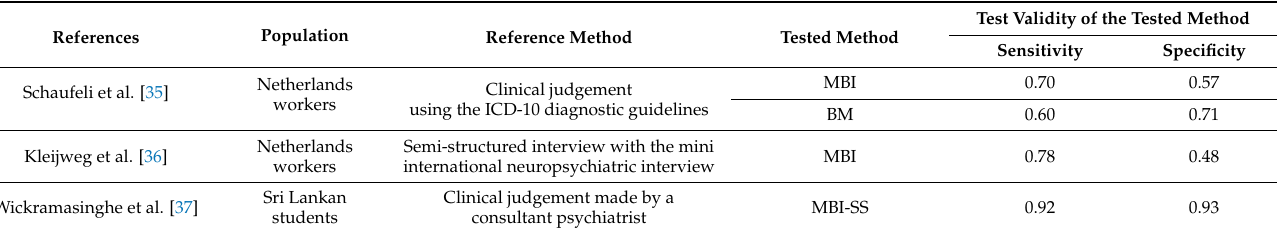
Table 1. Synthesis of main results among burnout